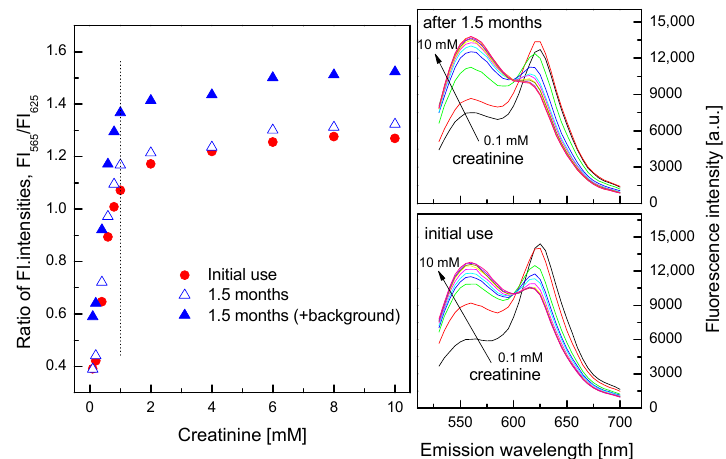
Figure 9. Long-term stability of the creatinine-sensing membrane at 0.1 to 10 mM creatinine concentration upon initial use and after 1.5 months of use ( left ). Two fluorescence emission spectra of the creatinine-sensing membrane with respect to creatinine concentrations at λ ex = 460 nm.